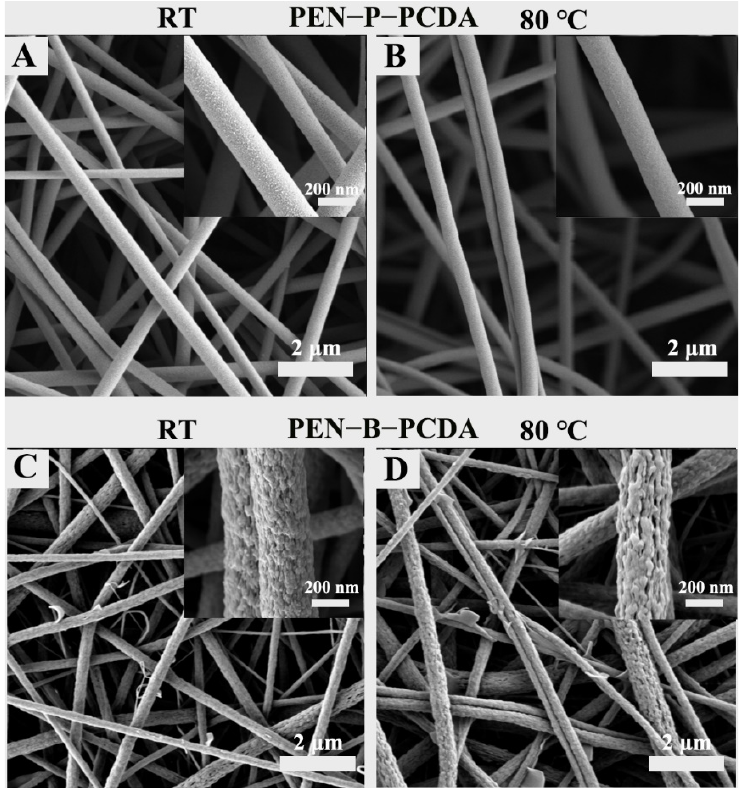
Figure 2. SEM images of PEN − P − PCDA and PEN − B − PCDA nanofibrous membranes at room temperature ( A , C ) and after exposure to 80 °C ( B , D ), with their corresponding local magnification images (inserts).